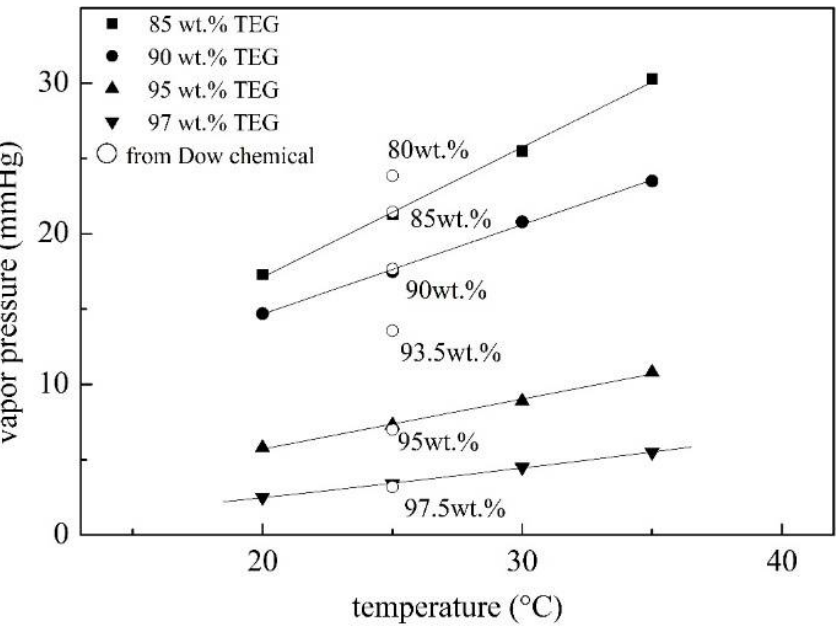
Figure 3. Vapor pressure of TEG aqueous solution.